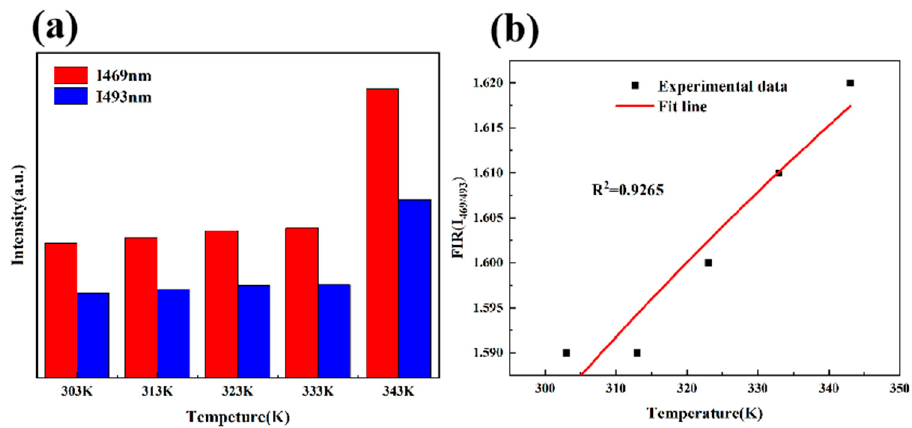
Figure 11. ( a ) The luminous intensity of the two emission peaks at 469 and 493 nm in the range of 303–343 K. ( b ) The fitting curve FIR (I 469 nm/I 493 nm) in the temperature range of 303–343 K.